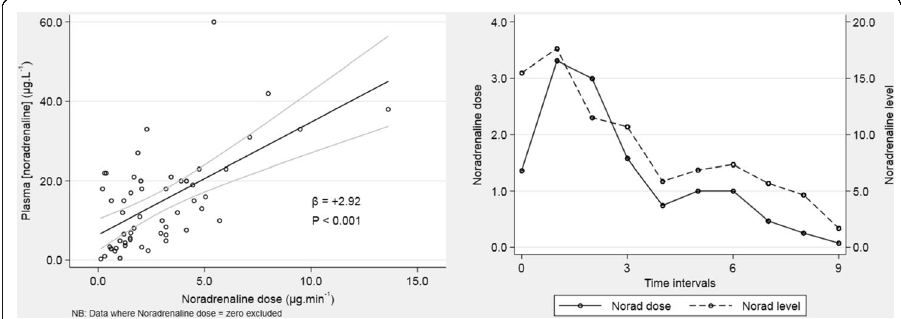
Fig. 6 Correlation of administered noradrenaline dose (mcg/min) and plasma noradrenaline level (pmolL − 1